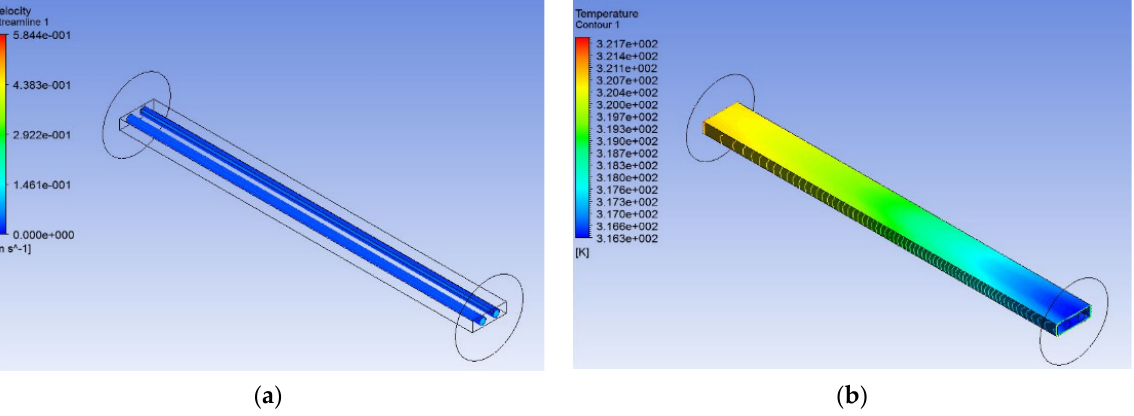
Figure 5. ( a ) Velocity contour starts from cold fluid duct with equally spaced sampling for 2 mm channel size. ( b ) Temperature contour of 2 mm channel size.